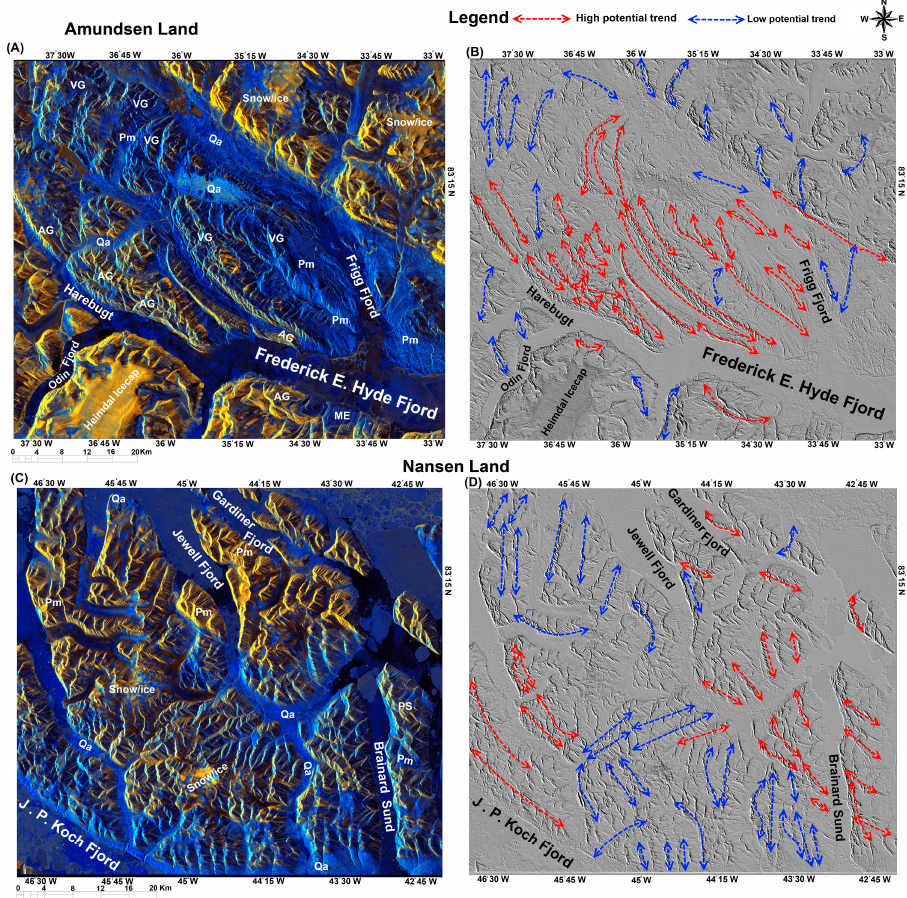
Figure 9. ( A ) FCC image map of PCA2, PCA3 and PCA5 for the PALSAR subset of the Amundsen Land; ( B ) NW–SE (135°) directional filter image derived from PCA2 for the subset of the Amundsen Land; ( C ) FCC image map of PCA2, PCA3 and PCA4 for the PALSAR subset of the Nansen Land; ( D ) NW–SE (135°) directional filter image derived from PCA2 for the subset of the Amundsen Land. Lithostratigraphic units are abbreviated as Pm = Polkorridoren Group, VG = Volvedal Group, ME = Merqujoq Formation; AG = Amundsen Land Group, Qa = Quaternary alluvium, and PS = Paradisfjeld